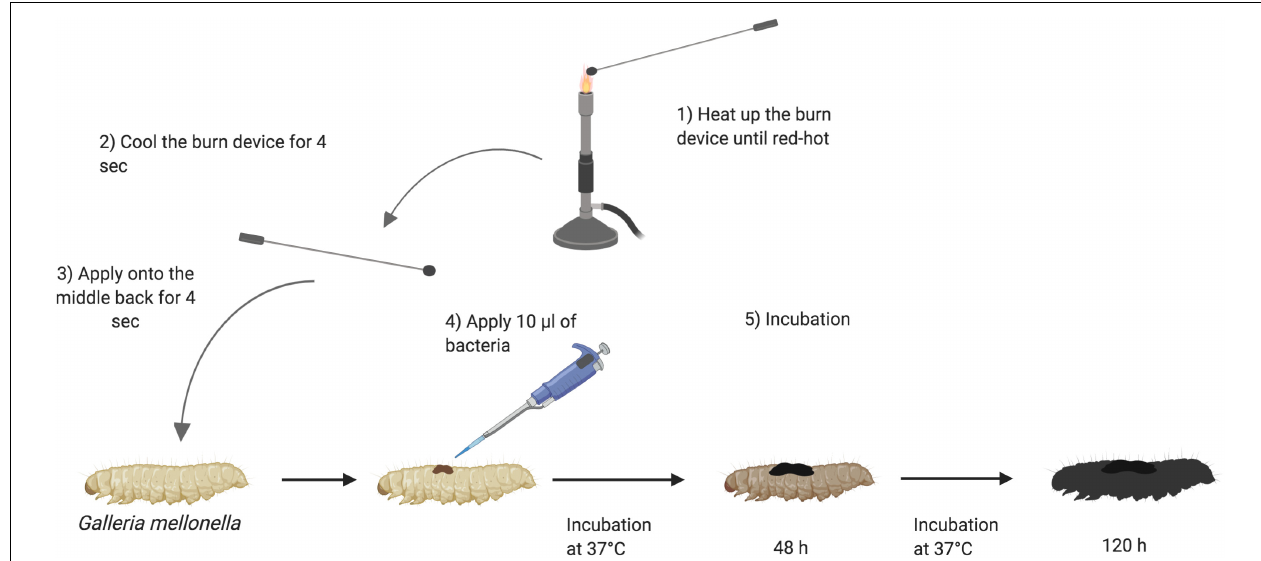
FIGURE 1 | Schematic outline of burn procedure: (1) Heating up the burn device in the middle of the flame of a Bunsen burner until the metal element is red/white-hot. (2) Cooling down the burn device near the flame for 4 s. (3) Applying the hot metal element to the middle segments of Galleria mellonella back for 4 s and slowly lifting it. (4) Applying 10 µ l of 1:10 dilution of over-night bacterial culture onto the fresh wound. (5) Larvae are incubated at 37 ◦ C for 120 h and monitored every 24 h. The darkness of Galleria signifies the intensity of infection (Wojda, 2017). Created with BioRender.